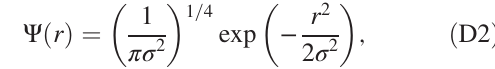
FIG. 13. Excitation rate Γ distances r 0 using the parameters from the experiment and Ω = 2 π ¼ 500 kHz. The excitation rate for r agrees well with the uncorrelated excitation rate r 0 → ∞ . The inset shows the same rates with linear